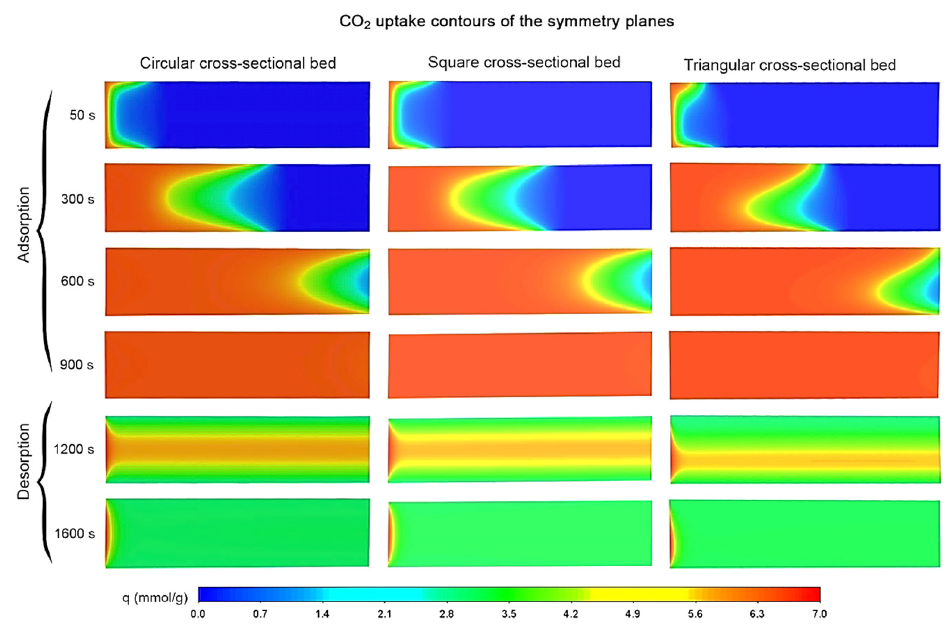
Figure 4. CO 2 uptake contours for the investigated beds at selective adsorption and desorption